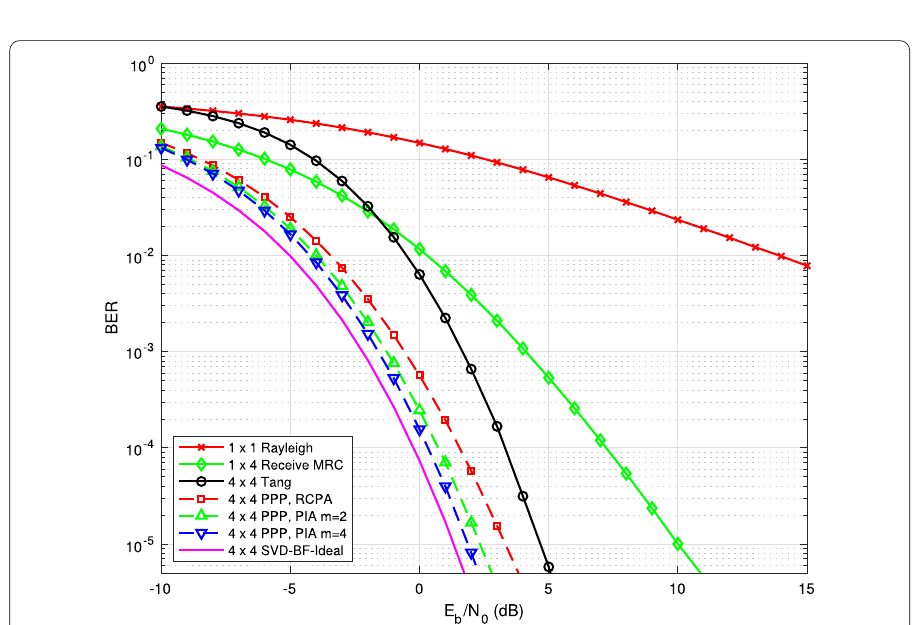
1 ), MRC receive diversity ( 1 4 ), Tang method [17] ( 4 × × 4 ) schemes (RCPA with m 1 , PIA with m 2 and m 4 iterations) versus ideal SVD × = = = 4 ) with ideal channel knowledge and ideal SVD ×